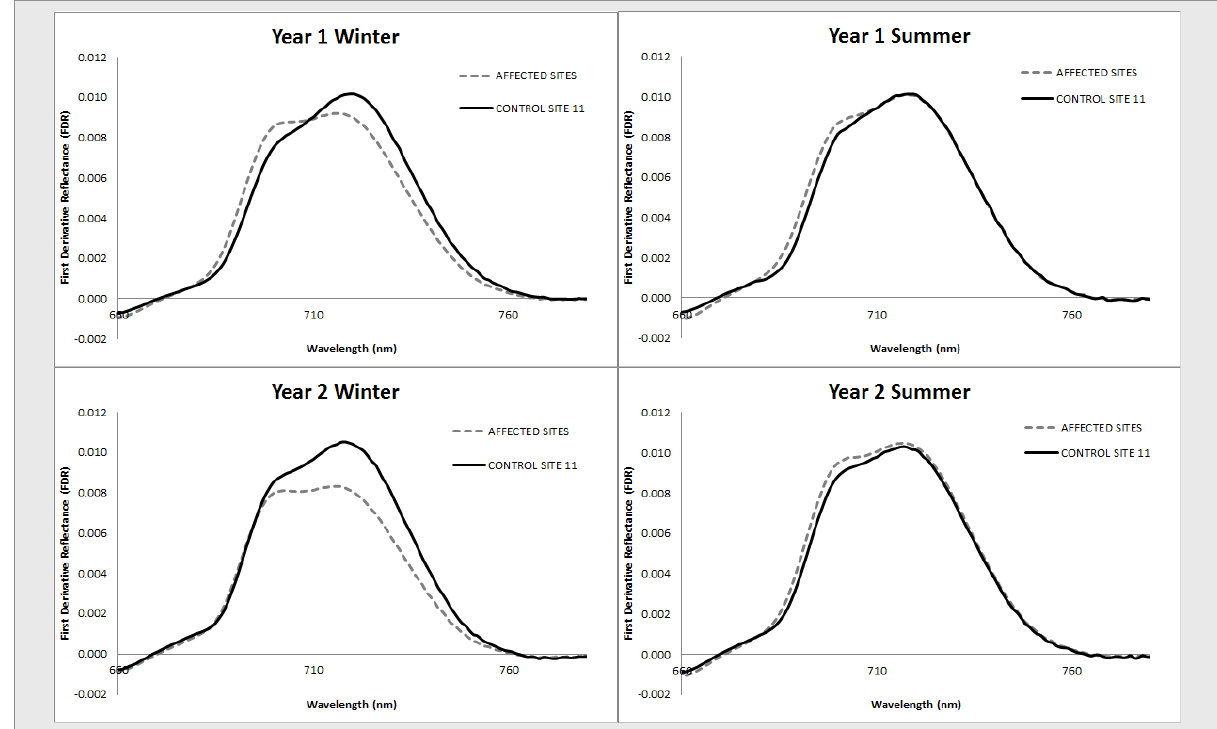
Figure 4: Comparison of first derivative reflectance curves of affected sites and the control site. The dominance of the first peak (at around 700 nm) is associated with low chlorophyll levels and the dominance of the second peak is associated with high levels of chlorophyll. The control site consistently shows dominance of the second peak over all seasons and years.